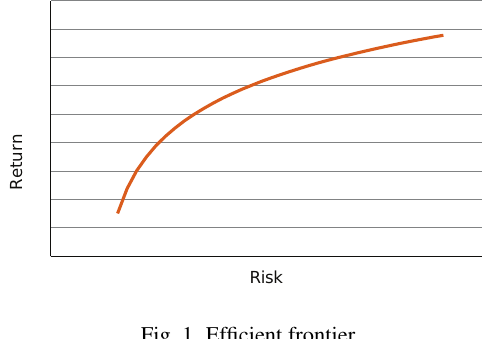
Fig. 1. Efficient